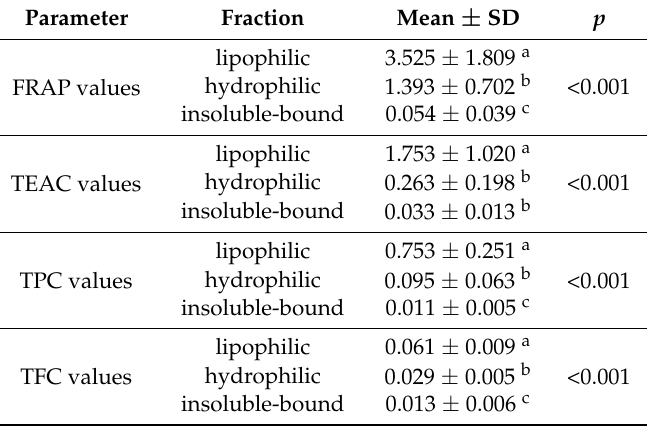
Table 1. Comparison of the antioxidant activities, TPC and TFC of lipophilic, hydrophilic, and insoluble-bound